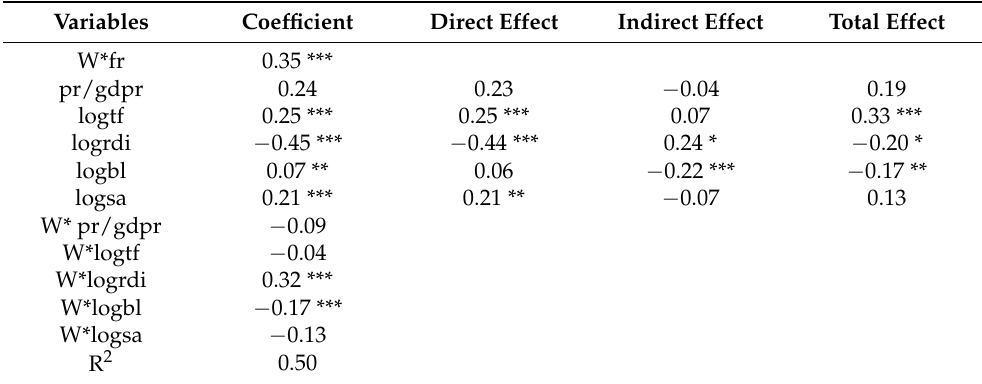
Table 9. Results of the SDM with spatial fixed effects for the middle region in